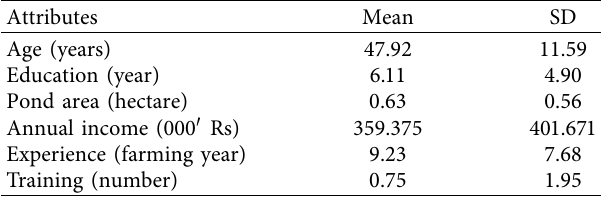
Table 1: Socioeconomic and demographic status of